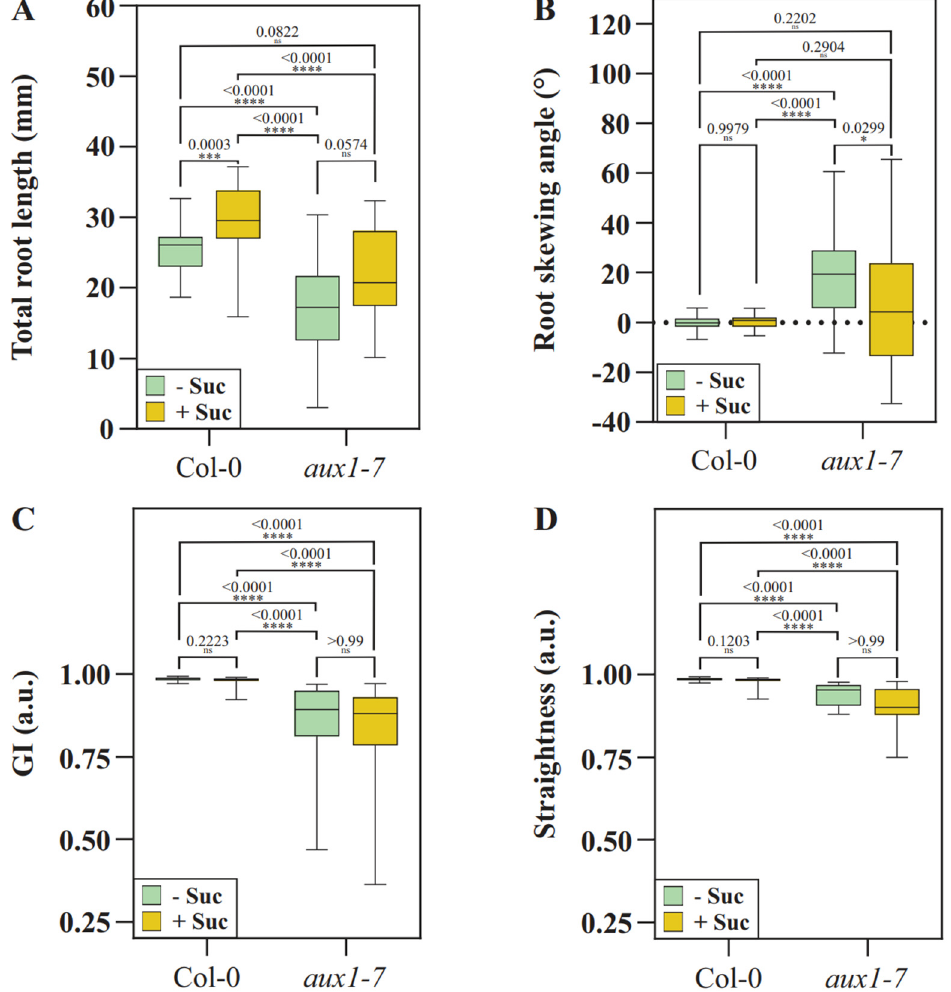
Figure 4. Analysis of root growth parameters: ( A ) root length, ( B ) skewing angle, ( C ) gravitropic index (GI), and ( D ) straightness. Only roots that showed total penetration into the medium were considered for analysis (Col-0, n = 38–50 roots; aux1-7 , n = 15–16 roots). Statistical analysis: data normality was assessed through the Shapiro–Wilk test. Normally distributed data were analyzed with a One-Way ANOVA and Tukey’s post hoc multiple comparison test. Not normally distributed data were analyzed via a Kruskal–Wallis test followed by Dunn’s multiple comparison test. * p < 0.05; *** p < 0.001; **** p < 0.0001.